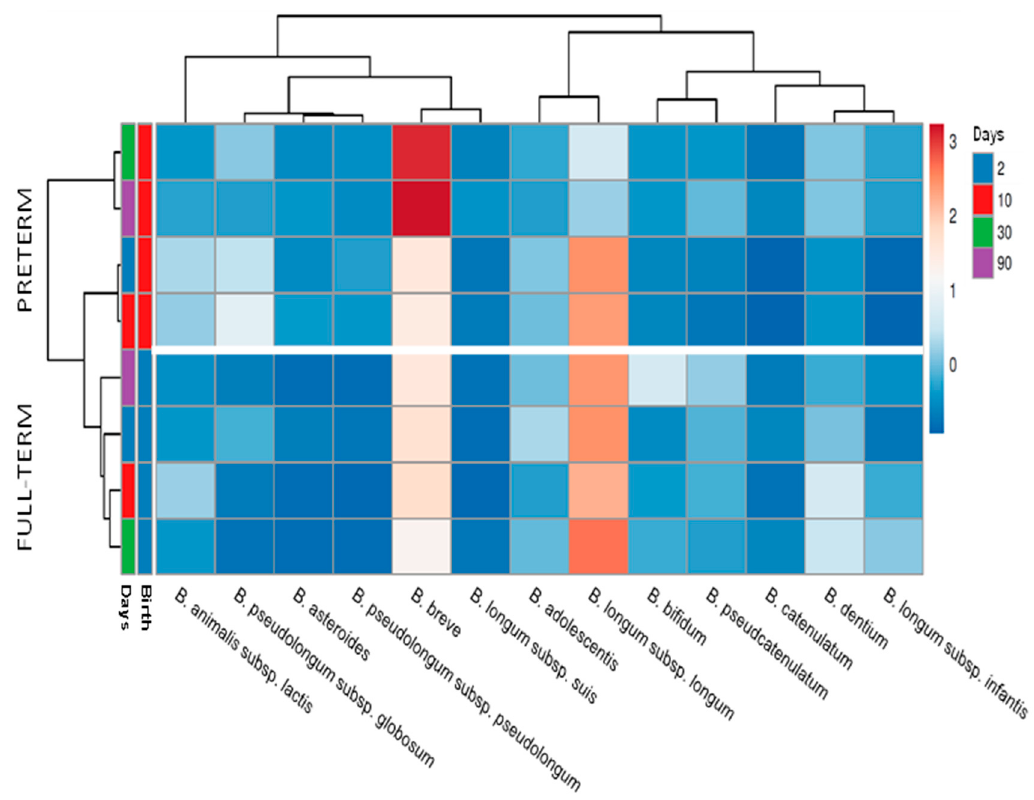
Figure 2. Heatmap showing the relative proportions of the different Bifidobacterium species/subspecies at two, 10, 30, and 90 days of age in full-term and preterm babies. The scale goes from blue (low relative frequency) to red (high relative frequency). Species/subspecies representing less than 1% were excluded from the analysis.